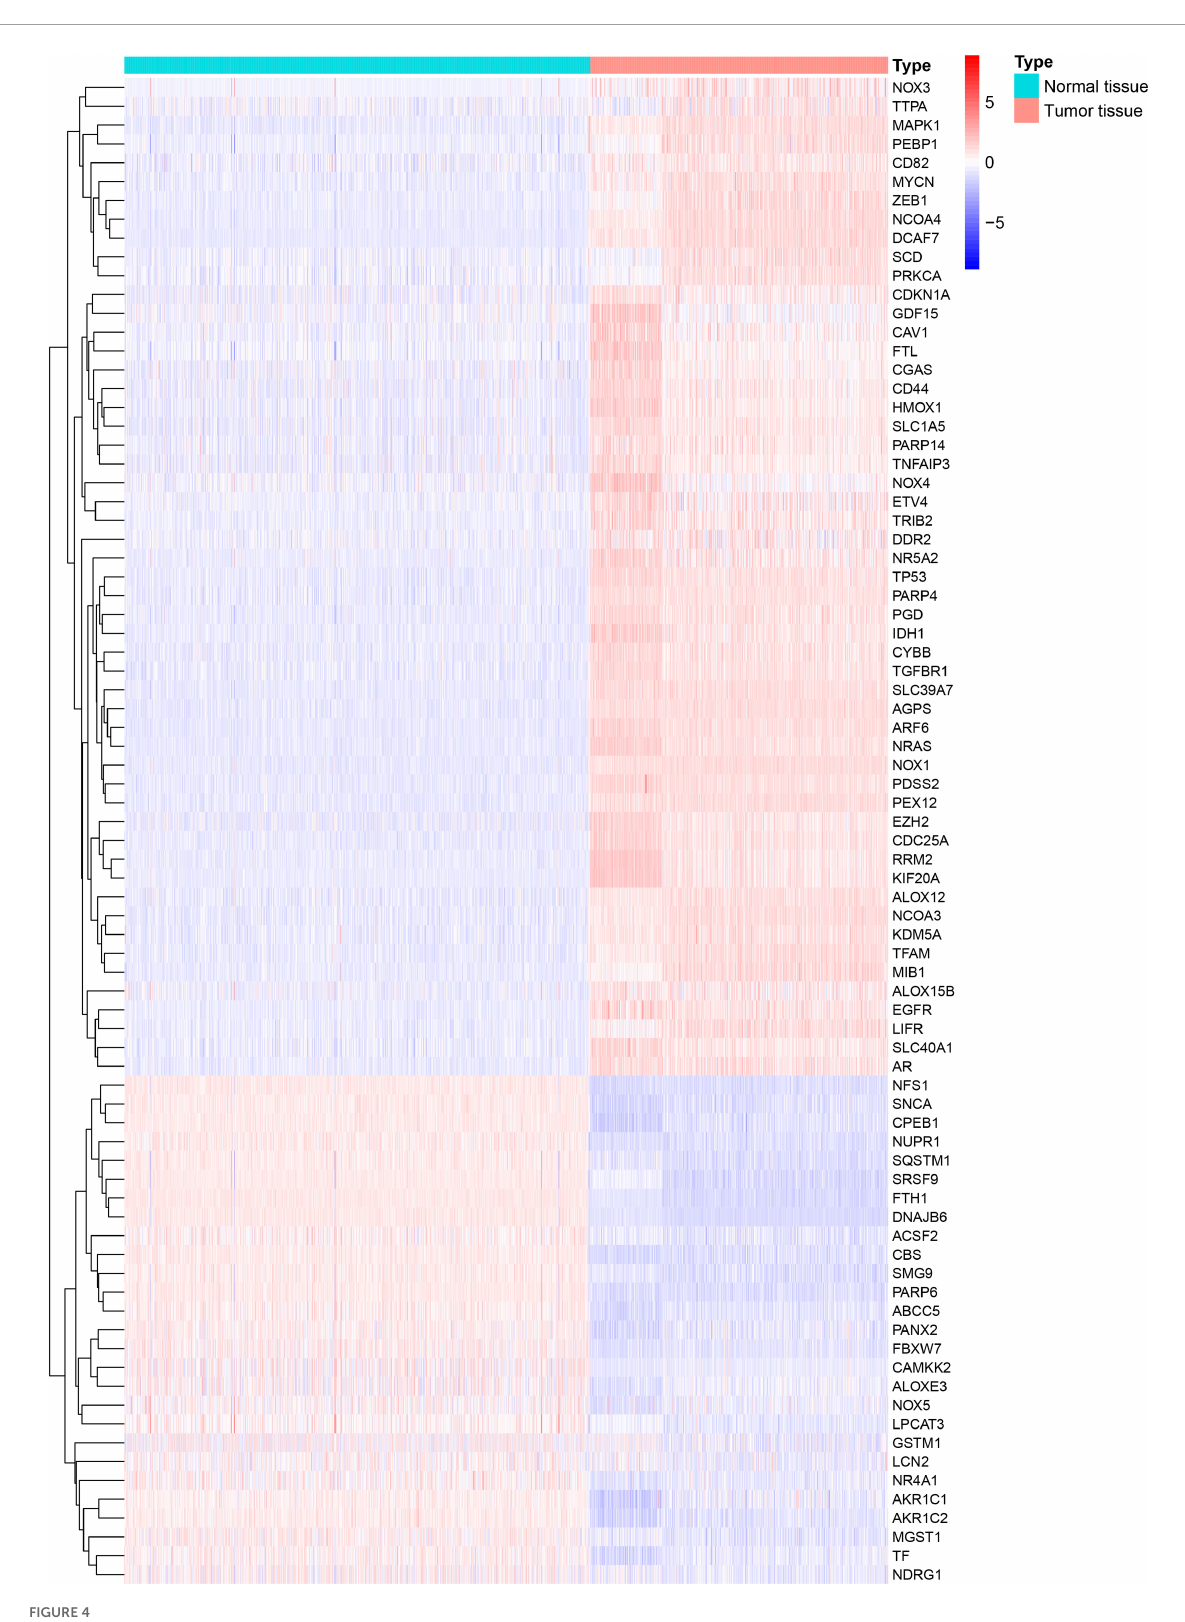
FIGURE4 Heatmap generated and displayed as log twofold